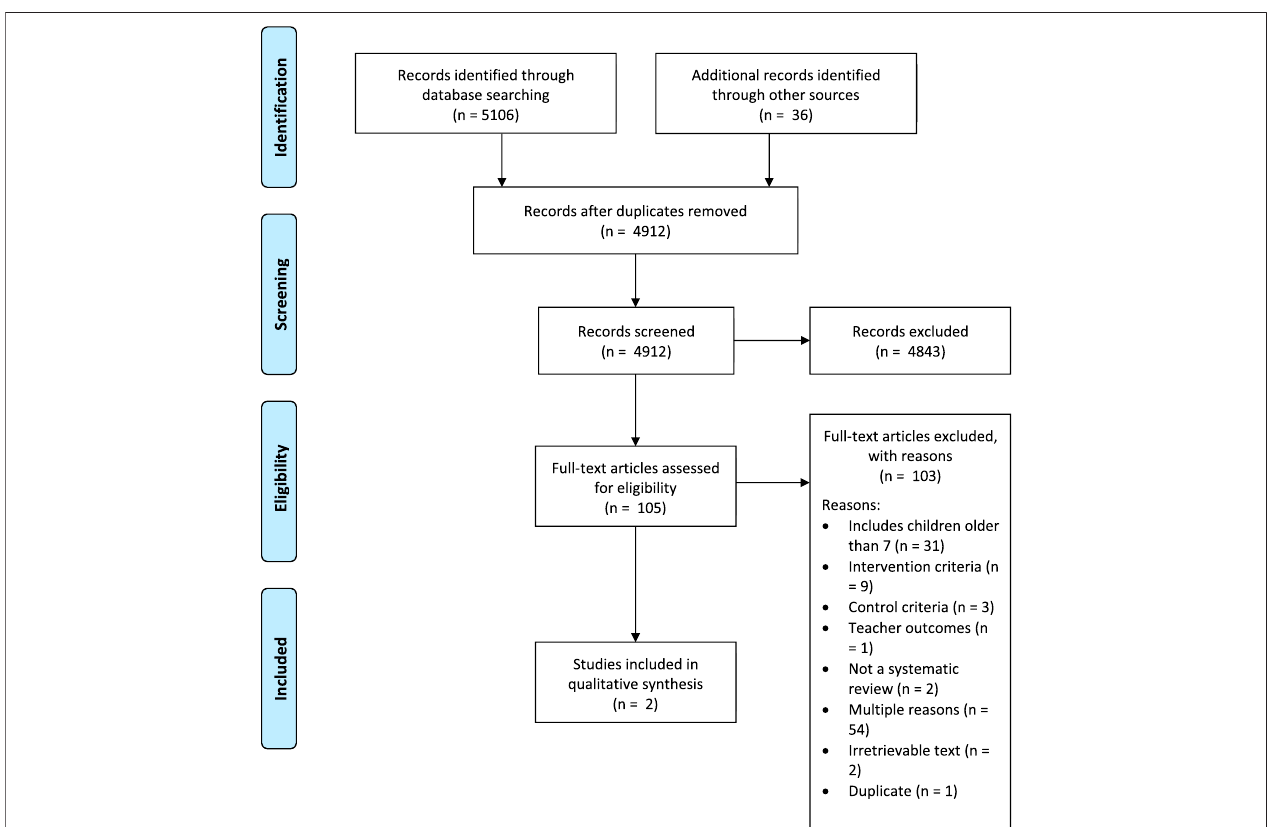
FIGURE 1 | PRISMA fl ow